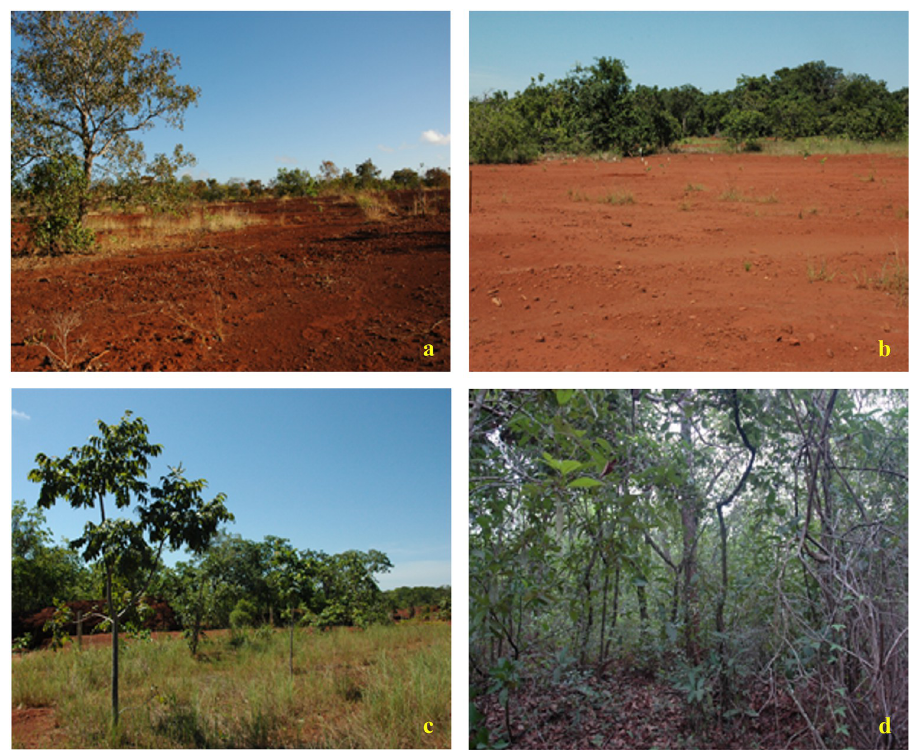
Fig 2. Experimental areas: (a) degraded area without intervention (DAWI), (b) AM00+BA00 receiving no amendments, (c) AM16+BA45 in 2016 after 5 years of soil conditioning treatments, and (d) undisturbed Cerrado (CER). (AM = aquatic macrophytes, BA = ash from sugar cane bagasse, applied at 00, 16 and 45 t ha -1